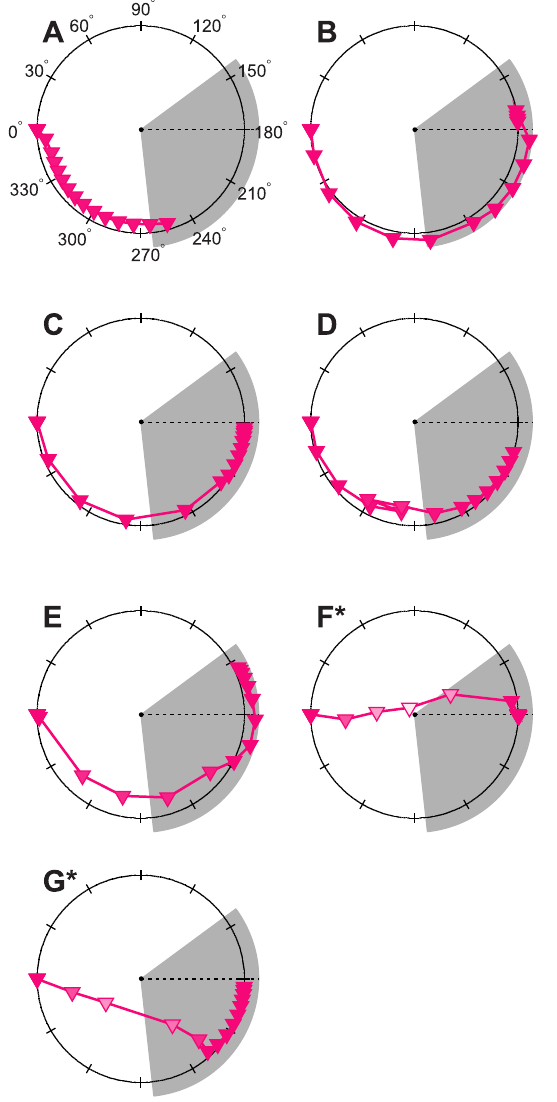
Figure 2. Polar phase-amplitude resetting maps corresponding to figure 1. Circadian phase is plotted in degrees, with 0 u corresponding to entrained CBTmin (before the schedule shift occurs), while amplitude is measured on the radius. A 6 hour advance would be indicated by a shift to 90 u , a 12 hour shift to 180 u , and a 6 hour delay to 270 u . The sleep/dark region is indicated by the shaded regions on the PARMs. The timing of entrained CBTmin in the new time zone is indicated by the dotted line. Figures ( A )–( G ) correspond directly to figures 1A–1G, with each subplot displaying the process re-entrainment under one of the six schedules considered in figure 1. The phase and amplitude of predicted CBTmin (magenta triangles) are plotted in a one-to-one correspondence with the markers of figure 1. In other words, the markers and lines of figure 1 are simply re-plotted here in phase-amplitude space. As in figure 1, re-entrainment is plotted for 4 days before the schedule shift and for 14 days after.